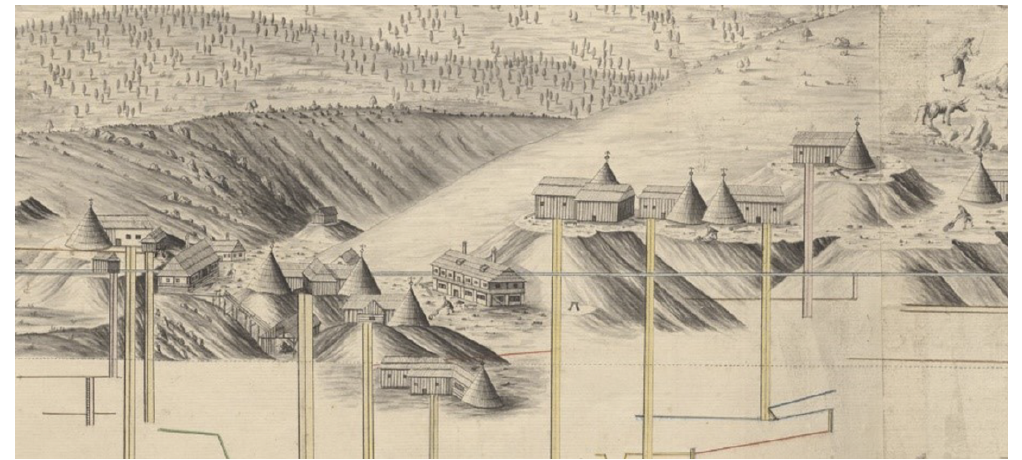
Figure 6. Mining technologies in Smolník in the 18th century (source: Slovak Mining Archive, Banská Štiavnica; the copy of the map was obtained in